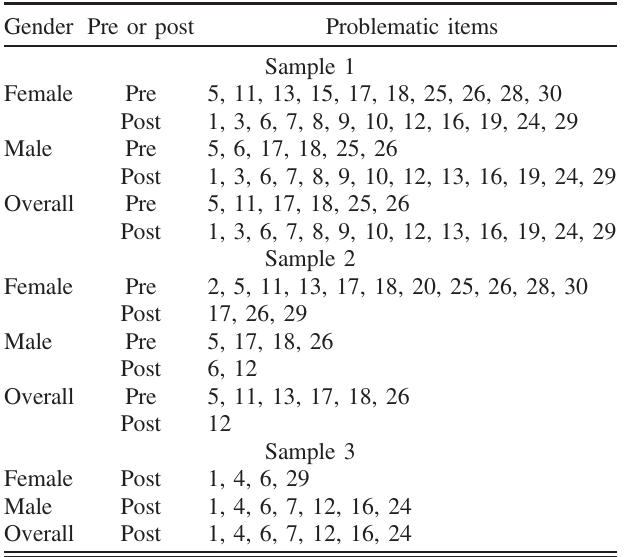
TABLE IV. CTT problematic items with P < 0 . 2 , P > 0 . 8 , or D < 0 . 2 . Gender Pre or post Problematic